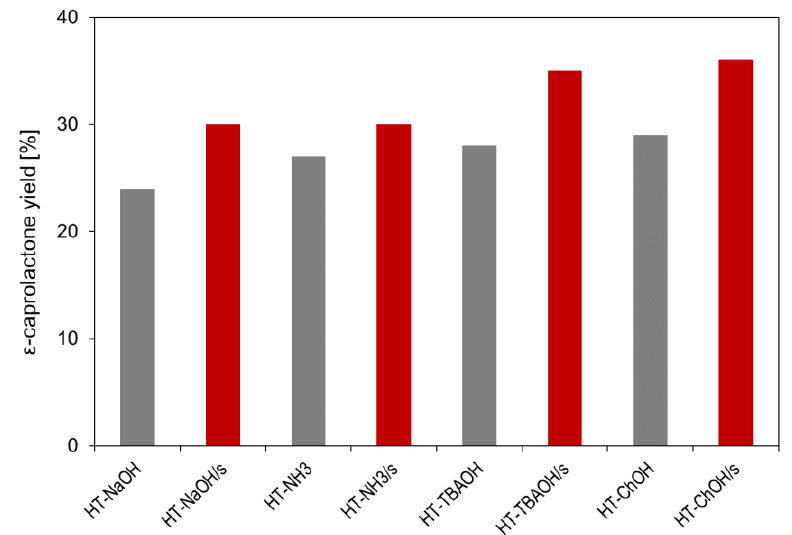
Figure 7. Yield of ε -caprolactone of HT materials obtained with the use of different precipitating bases in the presence or absence of starch. Reaction conditions: 0.125 g of catalyst, 12.5 mmol of cyclohexanone, 100 mmol of 30% H 2 O 2 , 200 mmol of acetonitrile, time = 3 h, temperature = 70 °C, batch reactor.